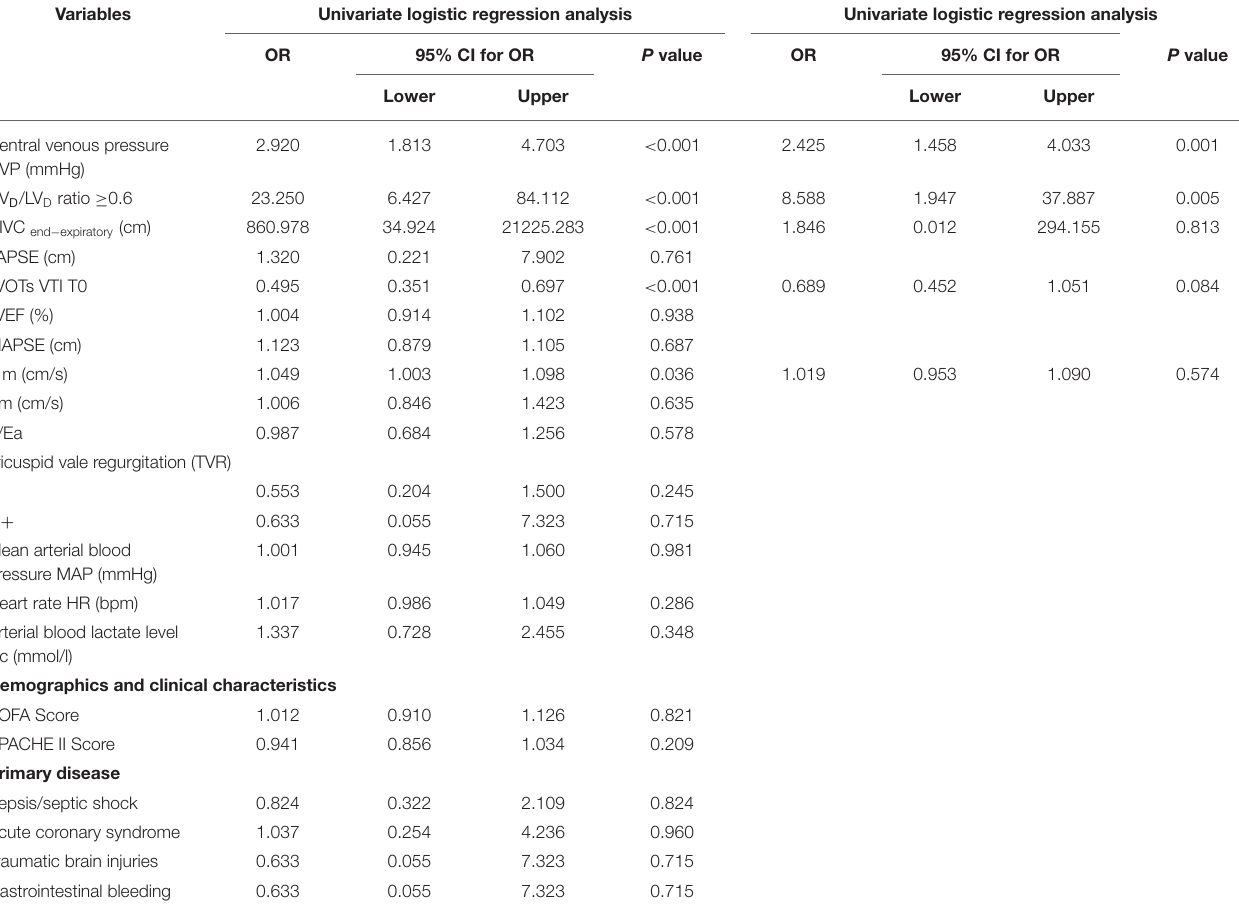
TABLE 3 | Logistic regression analysis for possible risk factors of LVOT VTI increased ≥ 10% after negative fluid balance. Variables Univariate logistic regression